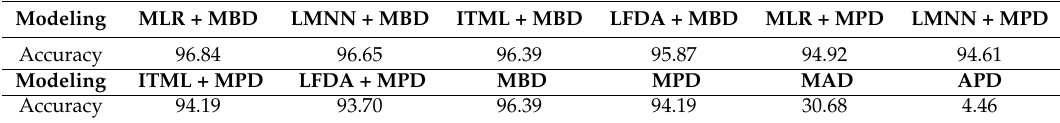
Table 7. Modeling component analysis on MLII.